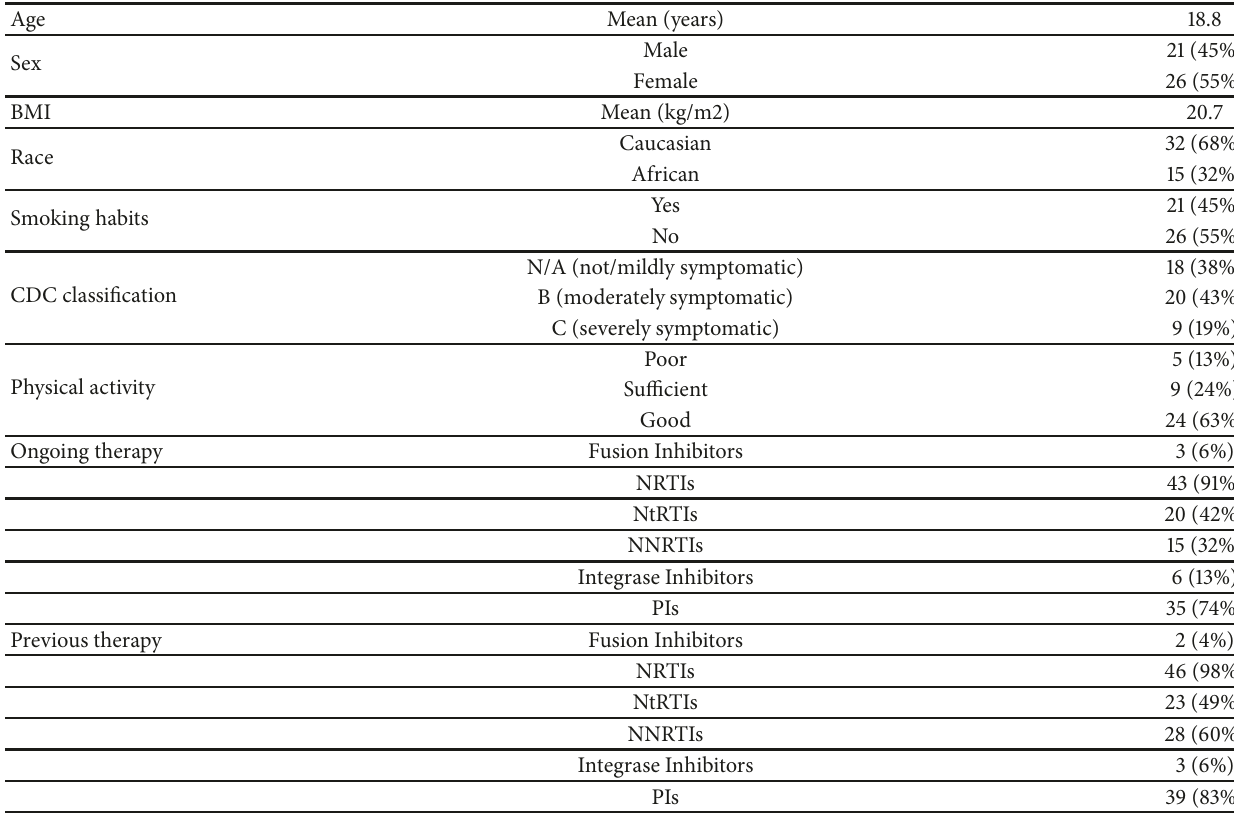
Table 2: Characteristics of the population that underwent